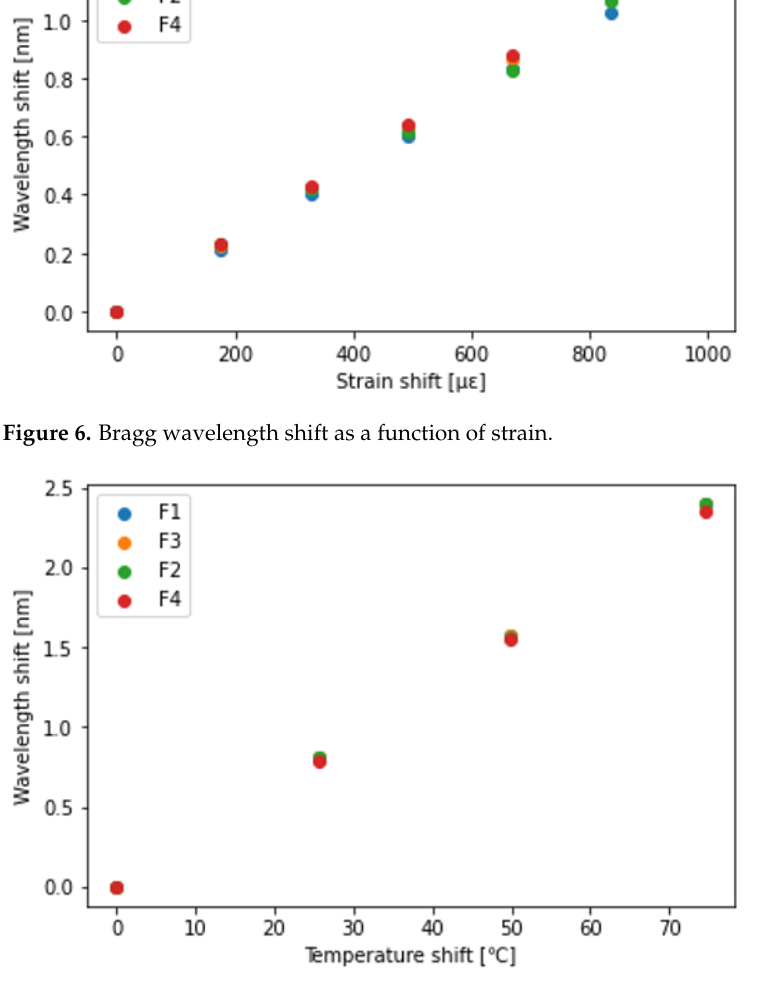
Figure 7. Bragg wavelength shift as a function of temperature.